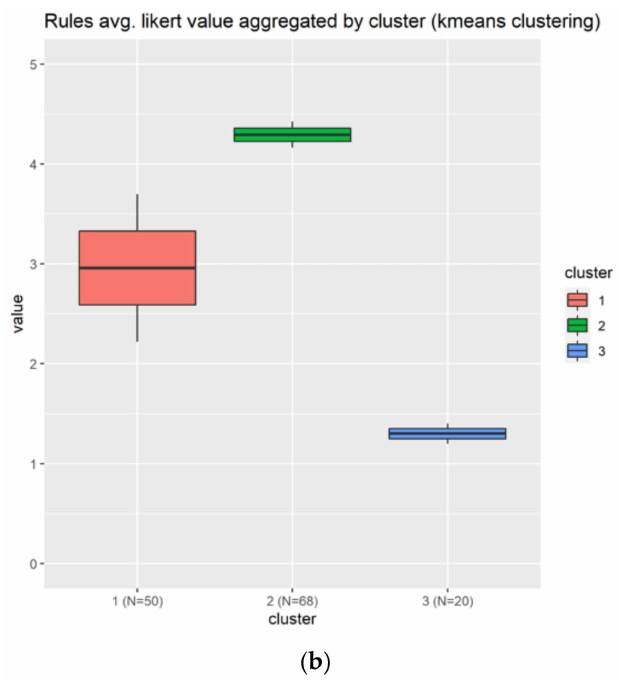
Figure 9. Results for the rules related questions. A total of two related questions in subplot ( a ) and three boxplots generated in subplot ( b